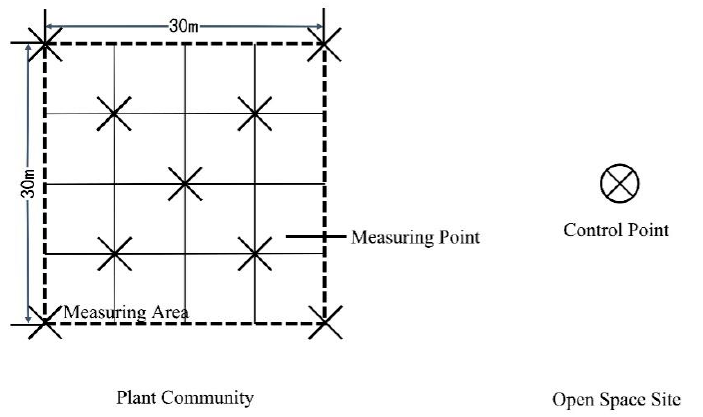
Figure 5. Schematic diagram of measuring and control point allocation in the trial site.